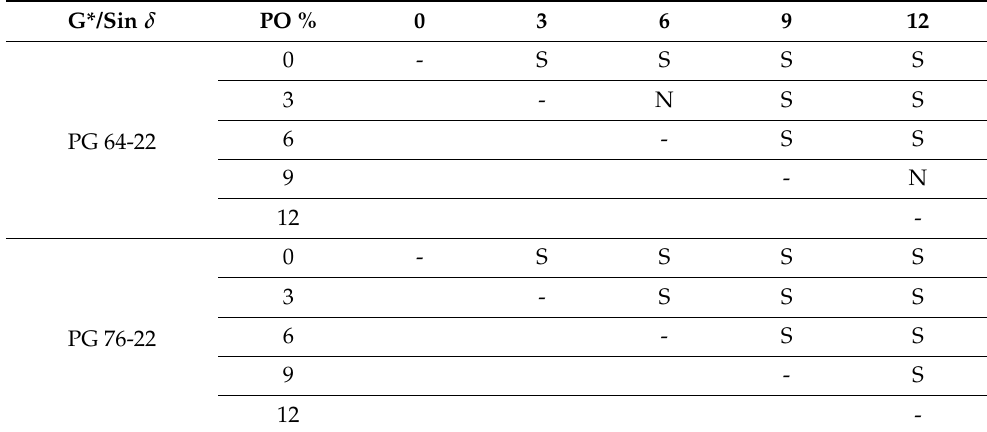
Table 6. Statistical analysis results of the G*/sin δ of RTFO test as a function of processed oil content ( α = 0.05).